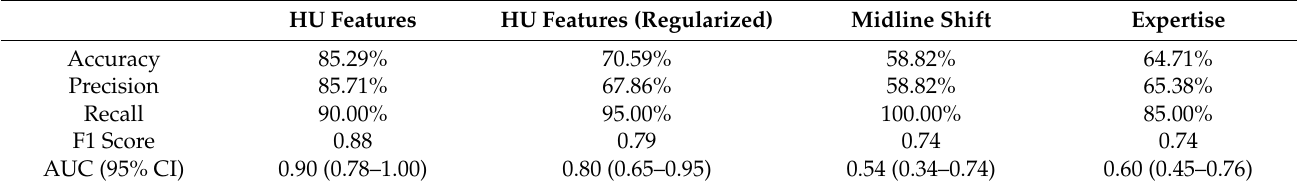
Table 3. Performance of models based on HU features (original and regularized), midline shift, and clinical expertise in unilateral TBI